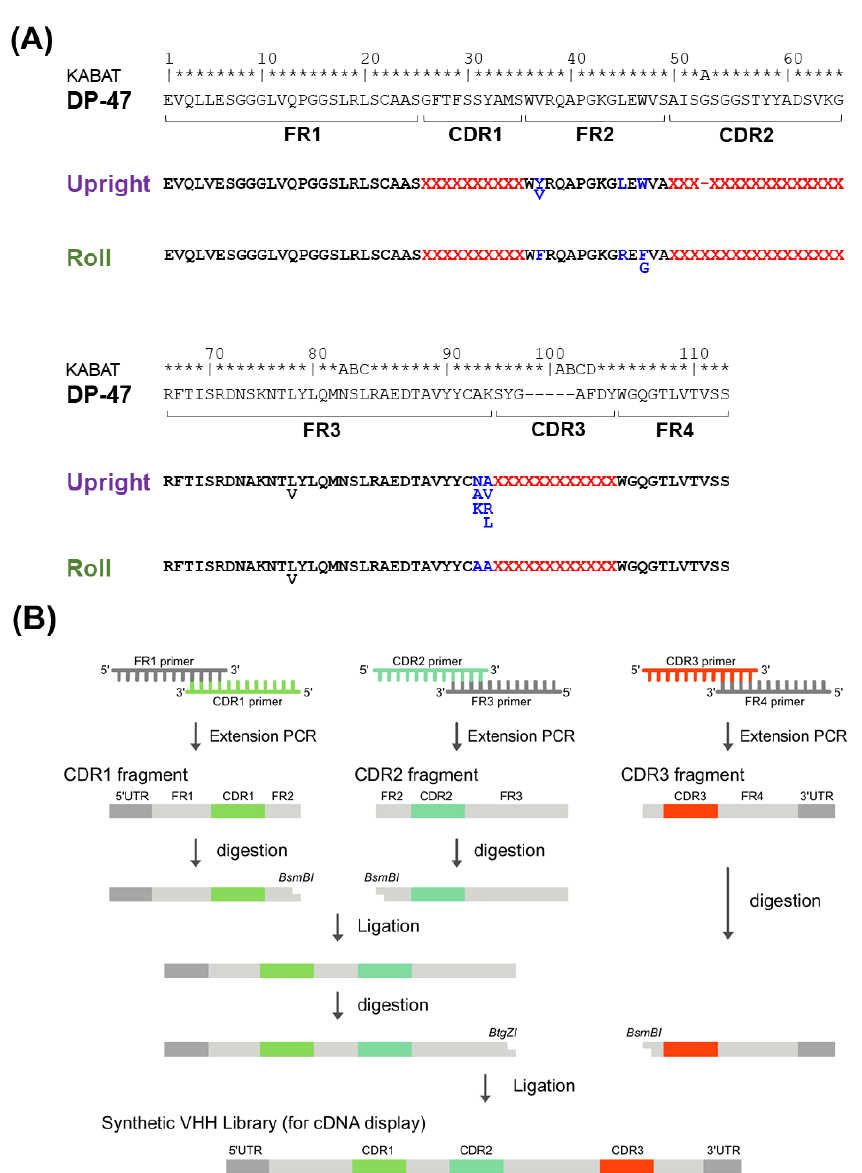
Figure 3. ( A ) The design of the humanized framework regions of the Upright and Roll sub-libraries and the humanized reference DP-47 are shown. The randomized CDR regions are shown in red. Sequences that differ between the Upright library and the Roll library are shown in blue. Numbering is according to the Kabat classification scheme. ( B ) The schematic diagram of the library construction process.